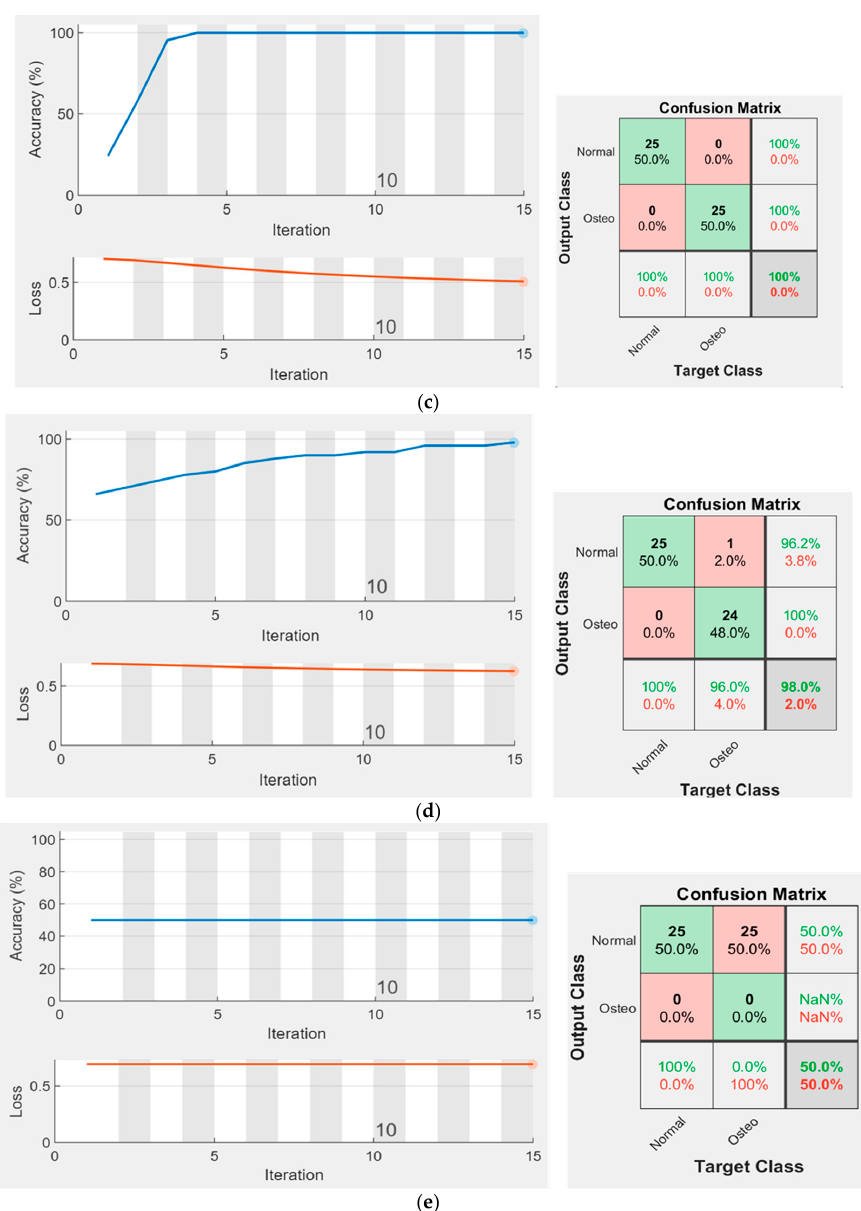
Figure A1. Ablation Study. ( a ) Original images only; ( b ) With roughness index; ( c ) With contrast index; ( d ) With phase index; and ( e ) With frequency index, green color indicate the same class while red indicate di ff erent class.